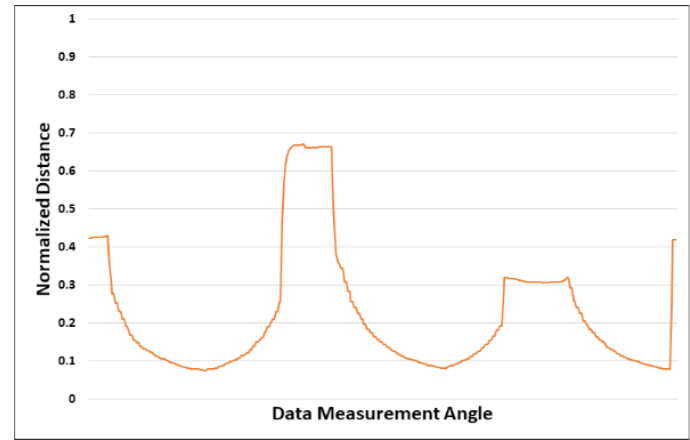
Figure 5. Normalized Range Data.